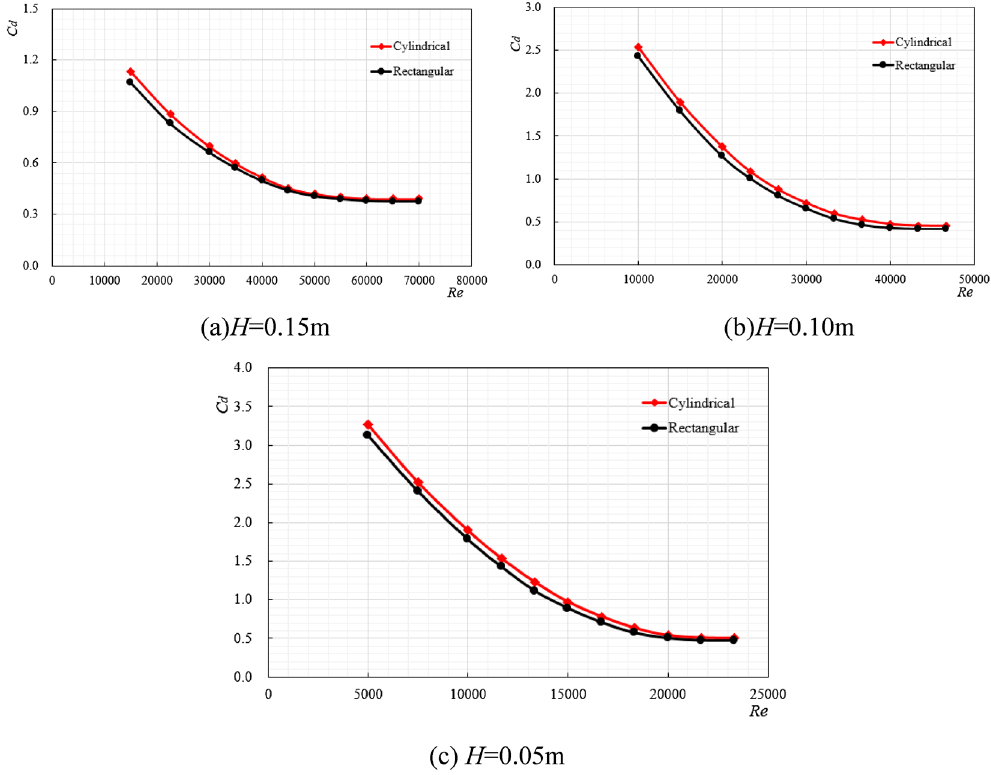
Figure 7. The resistance coefficient variation law diagram under different ore bin shape.